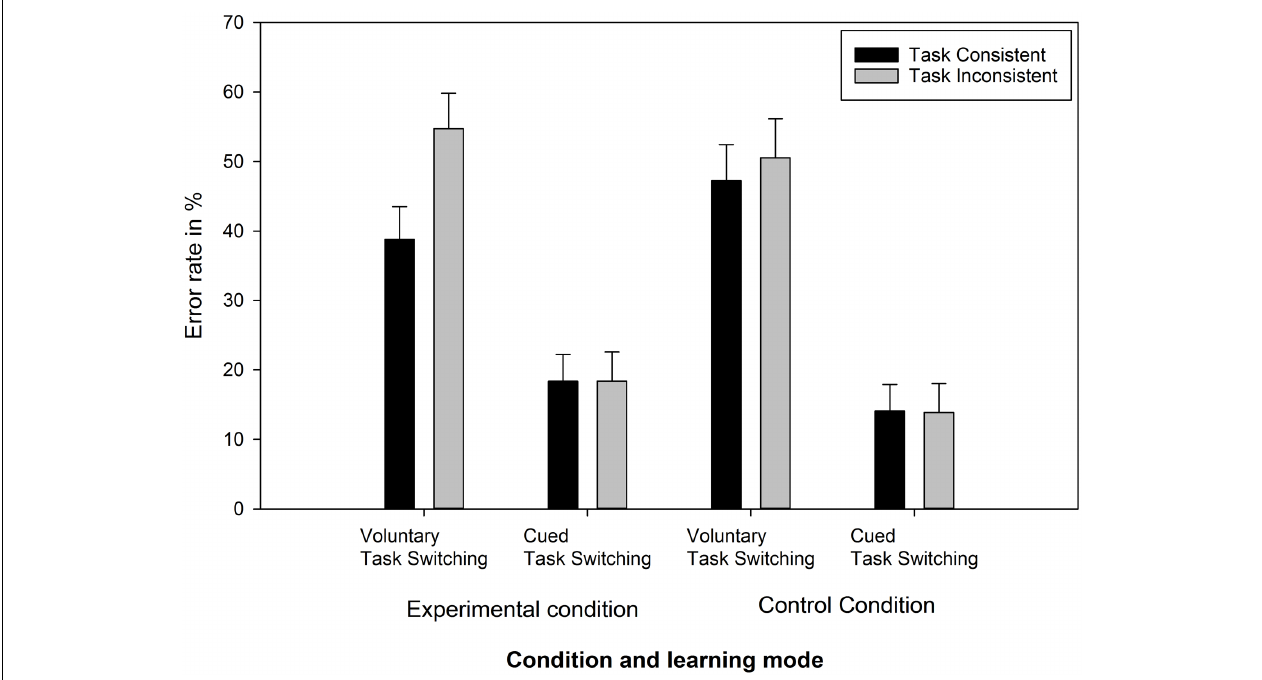
FIGURE 3 | Error rate in percent of Experiment 2 in the test phase as a function of experimental condition, learning mode in the acquisition phase and task consistency.